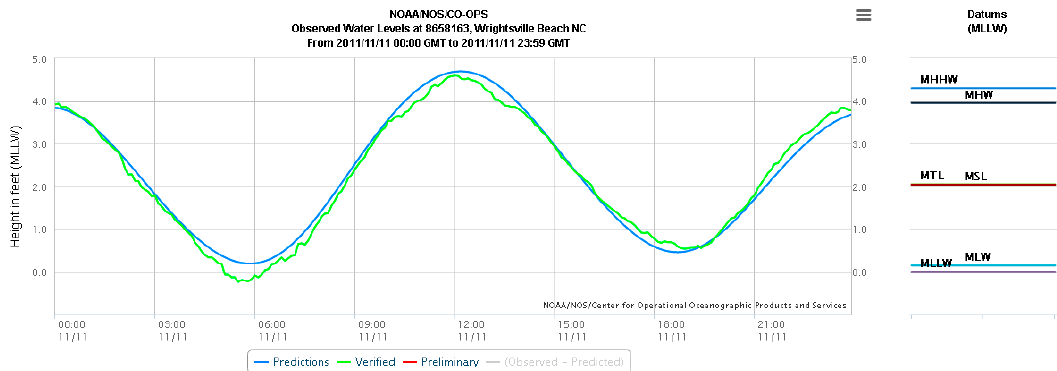
Figure A2. Verified tide height for adjusted WV-2 imagery acquisition time.